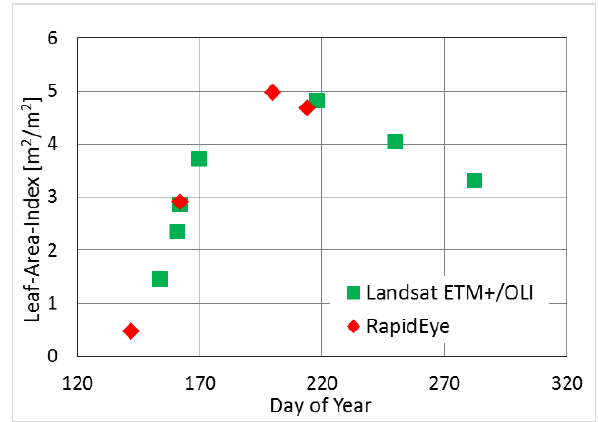
Figure 4: LAI retrieval for 2014 based on Landsat OLI/ETM+